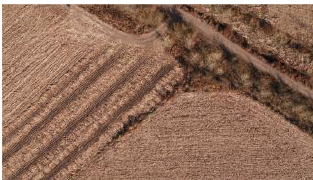
Figure 5. Original straw image with the height of 100 m.